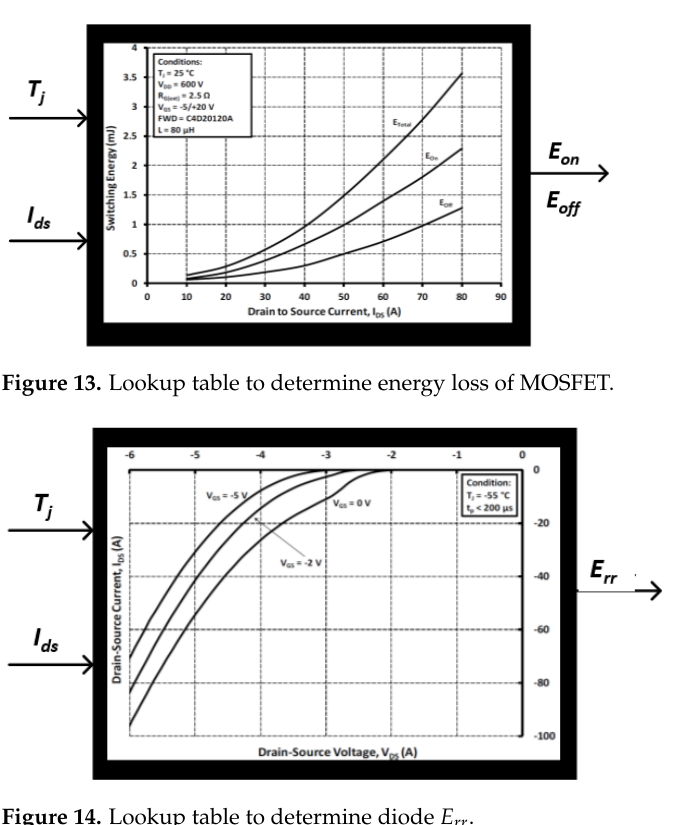
Ploss Figure 15. Third-order Cauer-type thermal network.